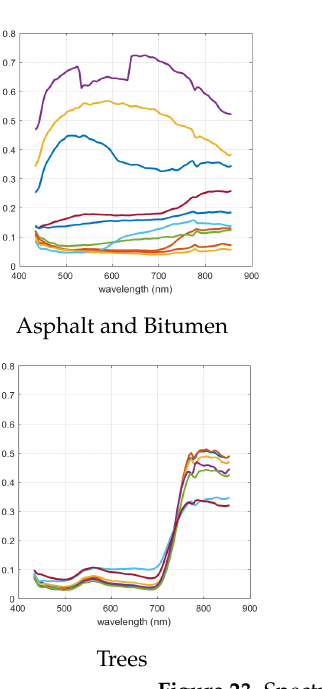
Figure 23. Spectral endmembers for each Pavia information class.